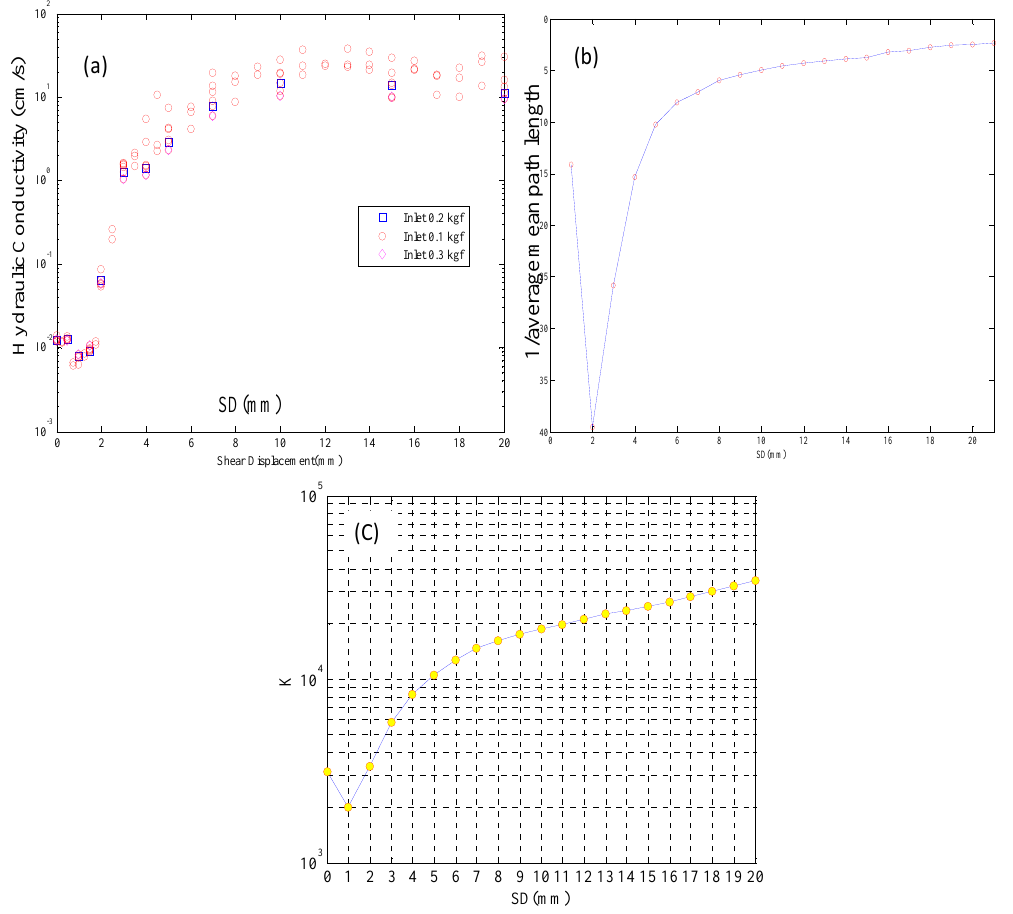
Fig. 3. Comparison of (a) hydraulic conductivity (measured through experimental laboratory tests – data set courtesy of M. Sharifzadeh) and (b) the inverse of the mean geodesic length of the parallel aperture networks (flipping Y-axis) and (c) evolution of edges degree with displacements in semi-logarithmic scale.